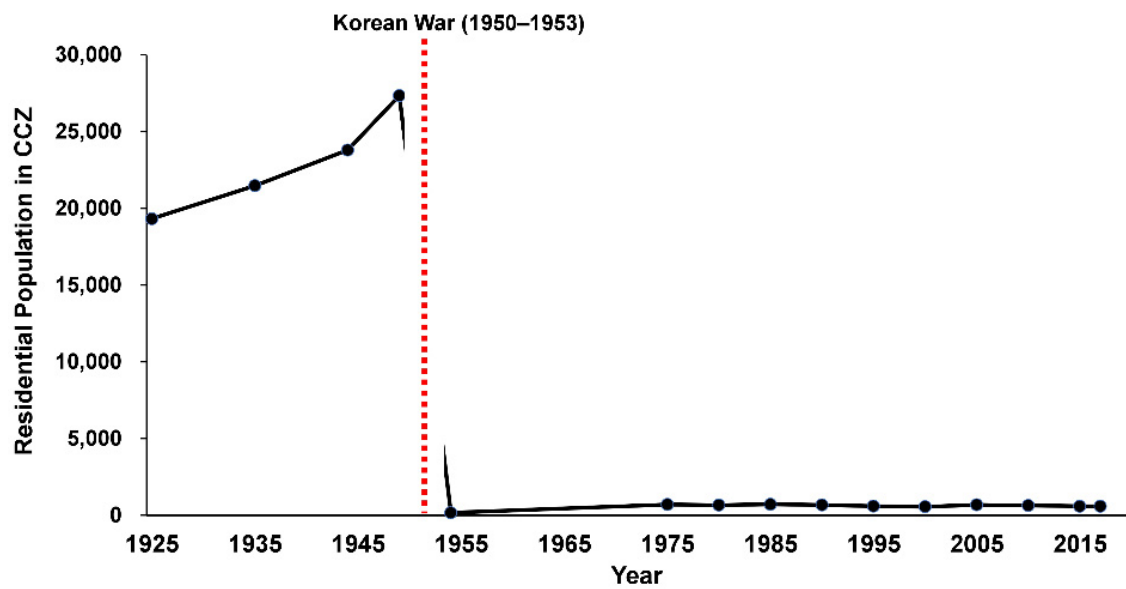
Figure 6. Population change in western CCZ in Paju. Since the division, a limited number of people have lived in civilian control areas.